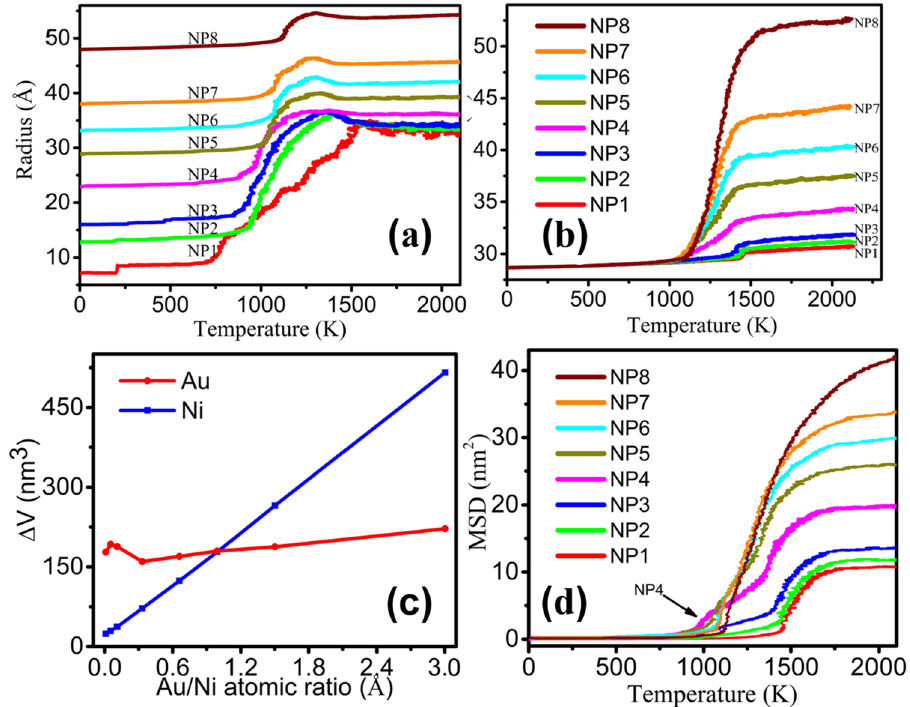
Figure 6. Evolution of radius of Au atoms ( a ) and Ni atoms ( b ) during heating process, ( c ) Volume change versus Au/Ni atomic ratio ( d ) MSD of